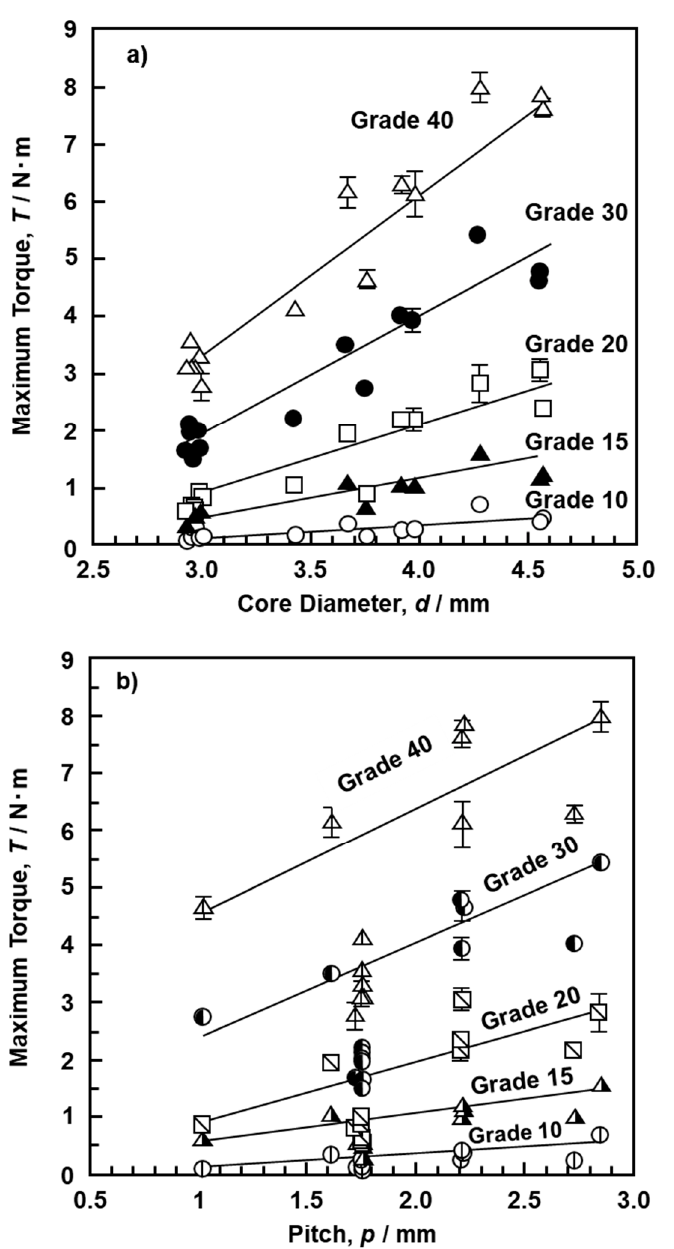
Figure 9. Effects of ( a ) core diameter and ( b ) pitch on maximum driving torque with cortical screws.